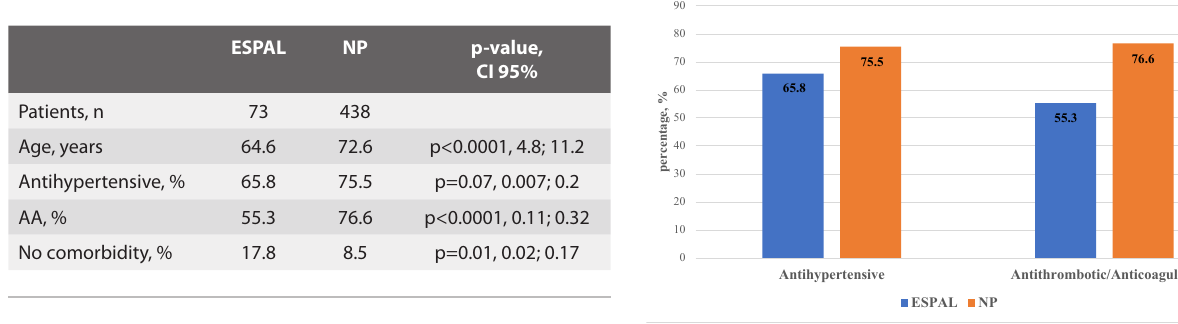
Table 2. Demographic differences between ESPAL and NP.